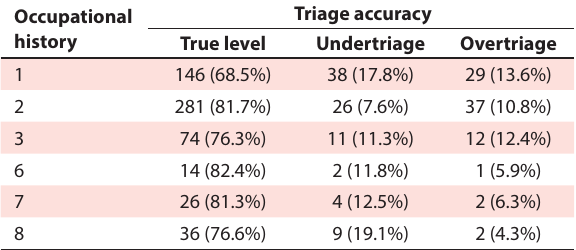
Table 2. The relationship between nurses’ experience and correct triage Occupational history